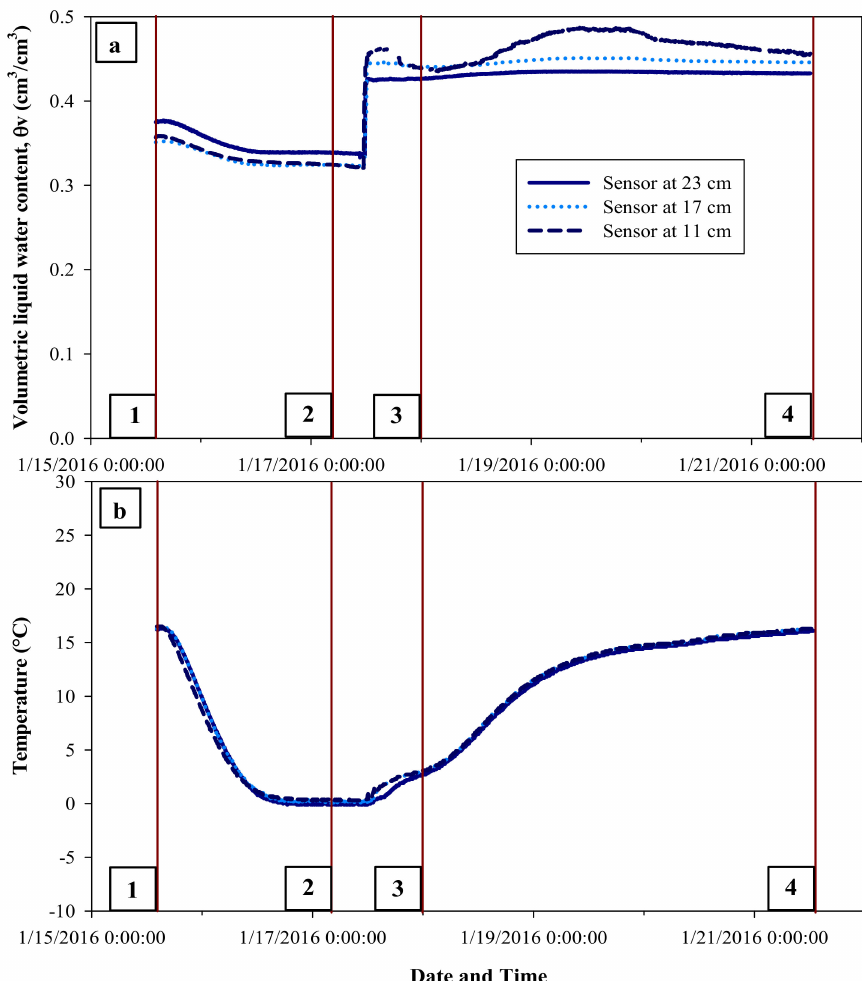
Figure 12. ( a ) Volumetric liquid water content ( θ v ) vs. time and ( b ) soil temperature vs. time, plotted for experimental Run 7 with initial water content condition at field capacity ( θ fc ). The vertical straight lines indicate (1) starting time of soil freezing and datalogging, (2) starting time of experimental run, (3) ending time of experimental run, and (4) ending time of